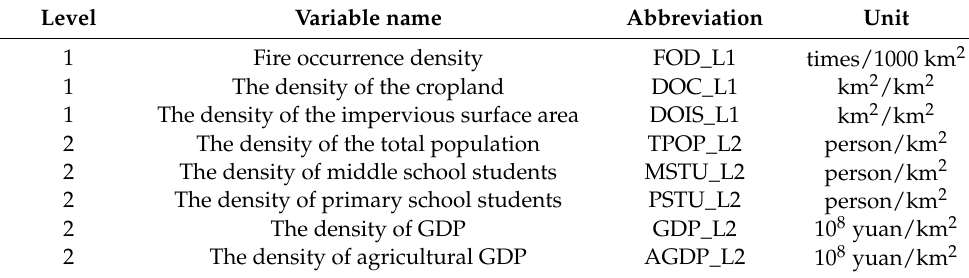
Table 1. Summary of variables for